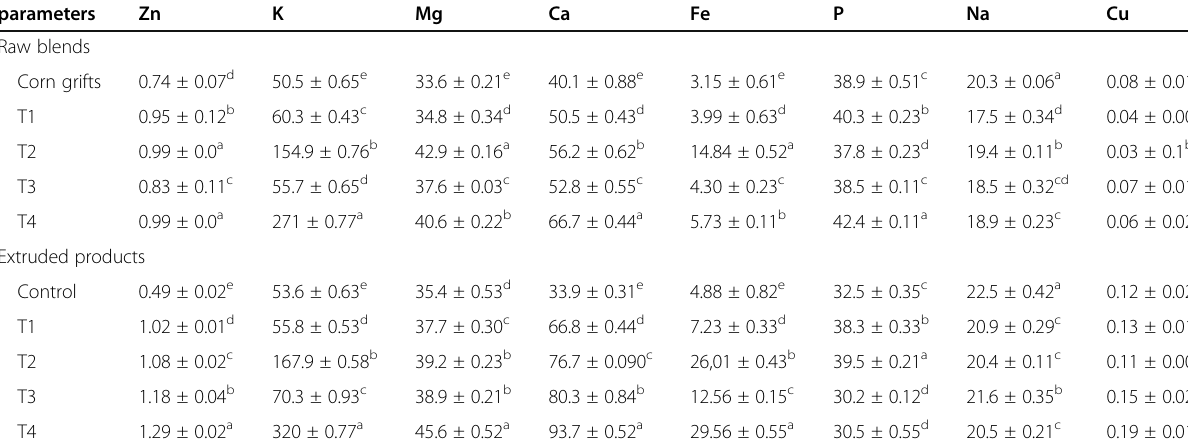
Table 4 Minerals composition of raw blends and extruded products (g/100 g) parameters Zn K Mg Raw blends